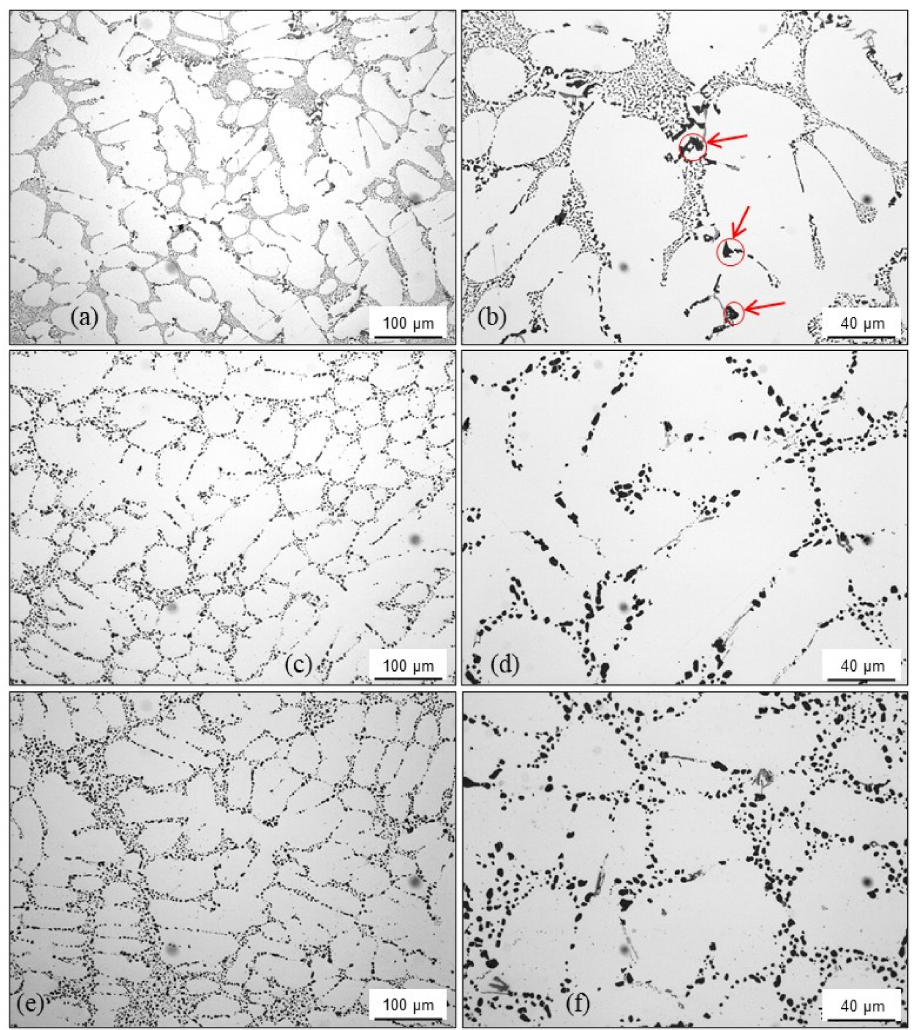
Figure 14. Optical micrographs of the alloy A356.2 used to produce the TA castings: ( a , b ) as cast microstructure, ( c , d ) after solubilization and quenching steps. Images ( e , f ) show the microstructure observed in a TA casting aged at 155 ◦ C for 200